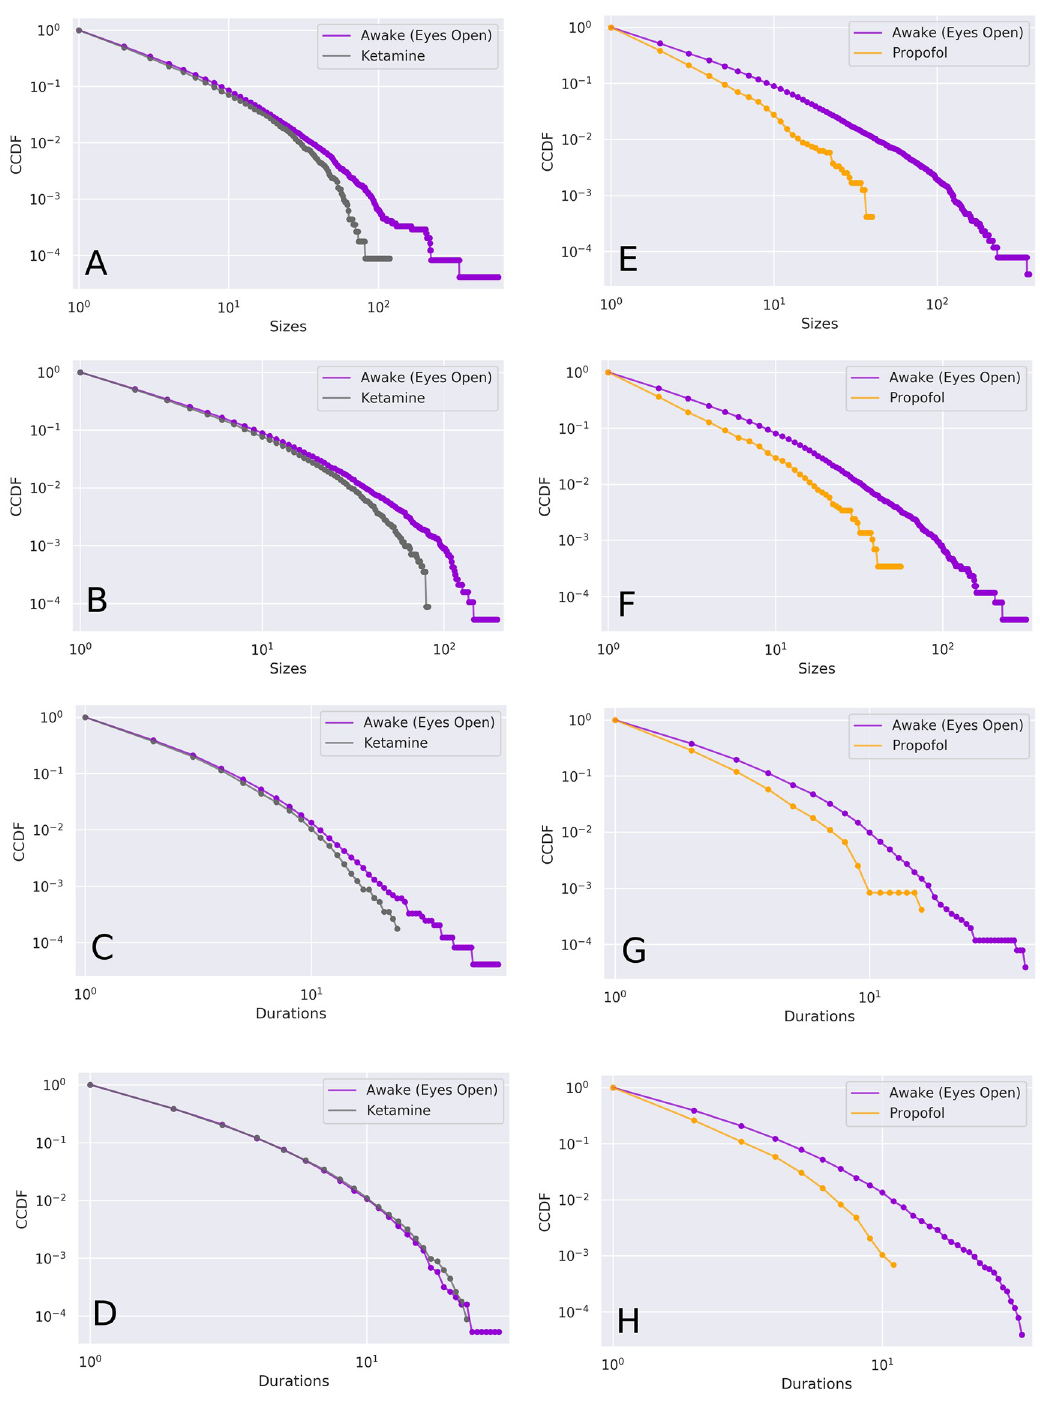
Fig 7. CCDFs of Avalanche Size and Duration by Condition. Comparison CCDFs for awake (purple) vs. ketamine (grey) and propofol (orange). Each plot includes two recordings: the anaesthesia condition (propofol or ketamine) and the associated pre- anaesthesia awake condition from the same monkey during the same session. Right panels: awake vs. ketamine. Left panels: awake vs. propofol. Avalanches sizes (top four panels) and durations (bottom four panels). Visual inspection shows that the ketamine condition tracks the awake condition much more closely than the propofol condition does: note how the propofol condition begins to drop below it’s associated awake distribution almost immediately, while the ketamine distribution tracks the awake distribution for a considerable range. This indicates that ketamine supports larger, longer-lived avalanches than propofol.